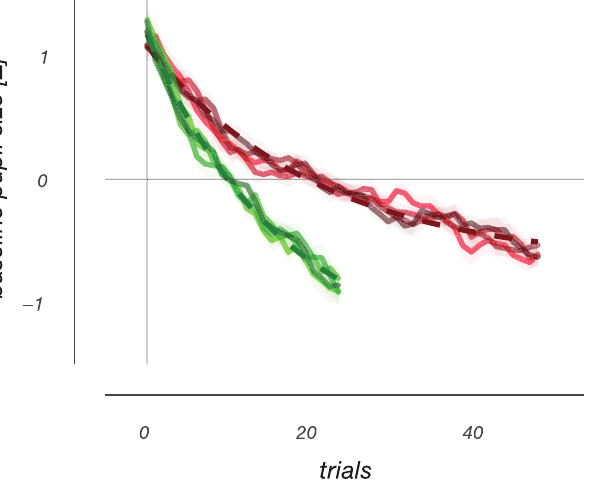
Fig 6. Slow exponential decrease of tonic pupil size over time. During a single run, tonic pupil size starts high and falls over the course of the run. Two experimental versions had different amounts of trials per recording run and are plotted in different colors. For the red line, trials had an average duration of 3 s, whereas for the green line the average trial duration was 5 s. The different lines per experimental version depict the tonic pupil timecourse for the different experimental conditions, ordered as in Fig 6, and show no difference between conditions. The dashed lines are best- fitting exponential curves. When accounting for the difference in average trial duration, the time constants of these fits are roughly similar, with a slight ~20% difference.